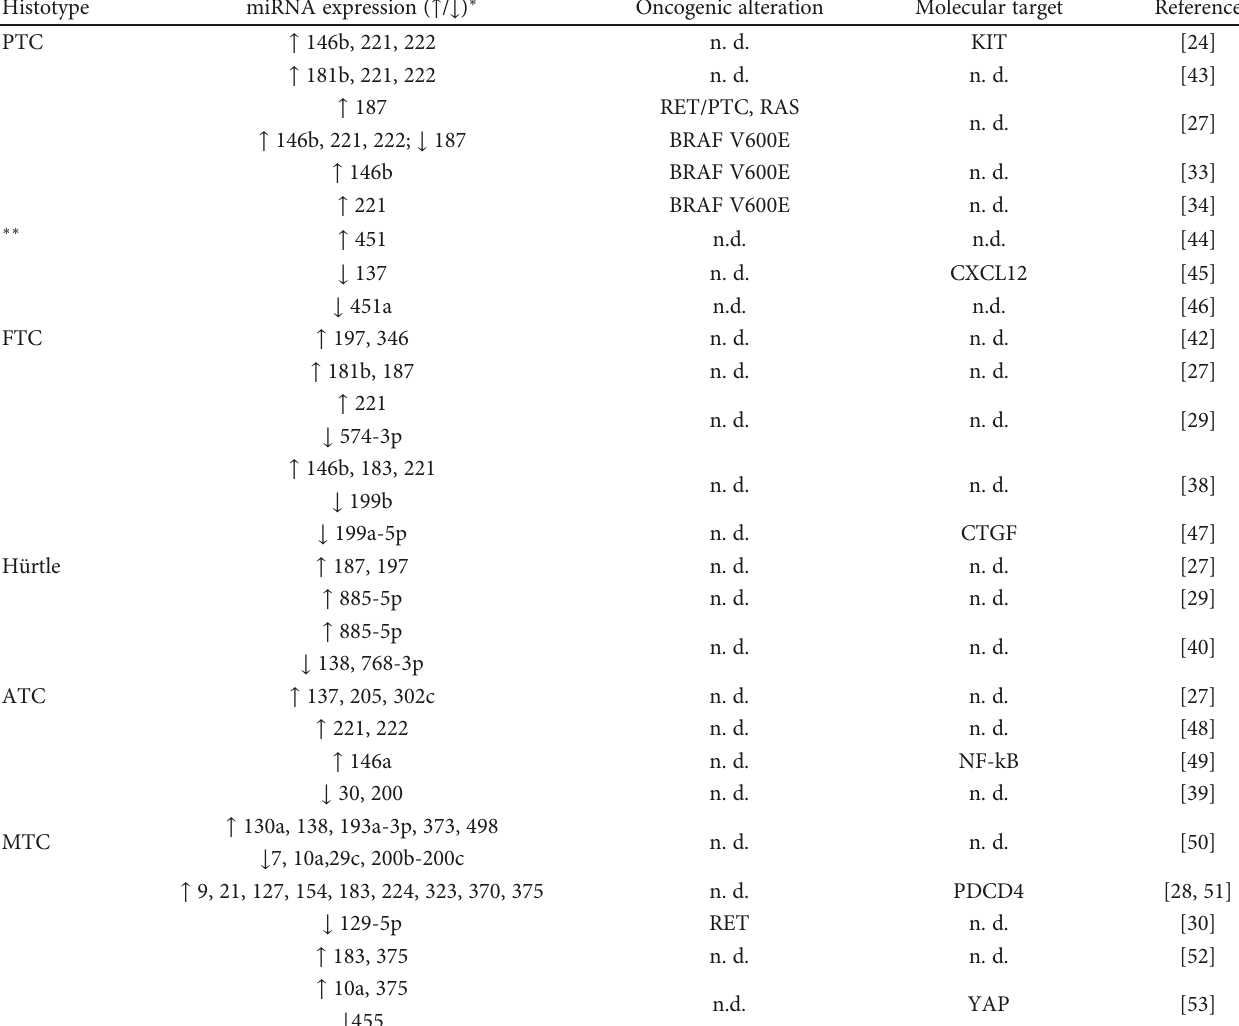
Table 1: Known targets for deregulated miRNAs in thyroid tumors and association with genetic alterations.